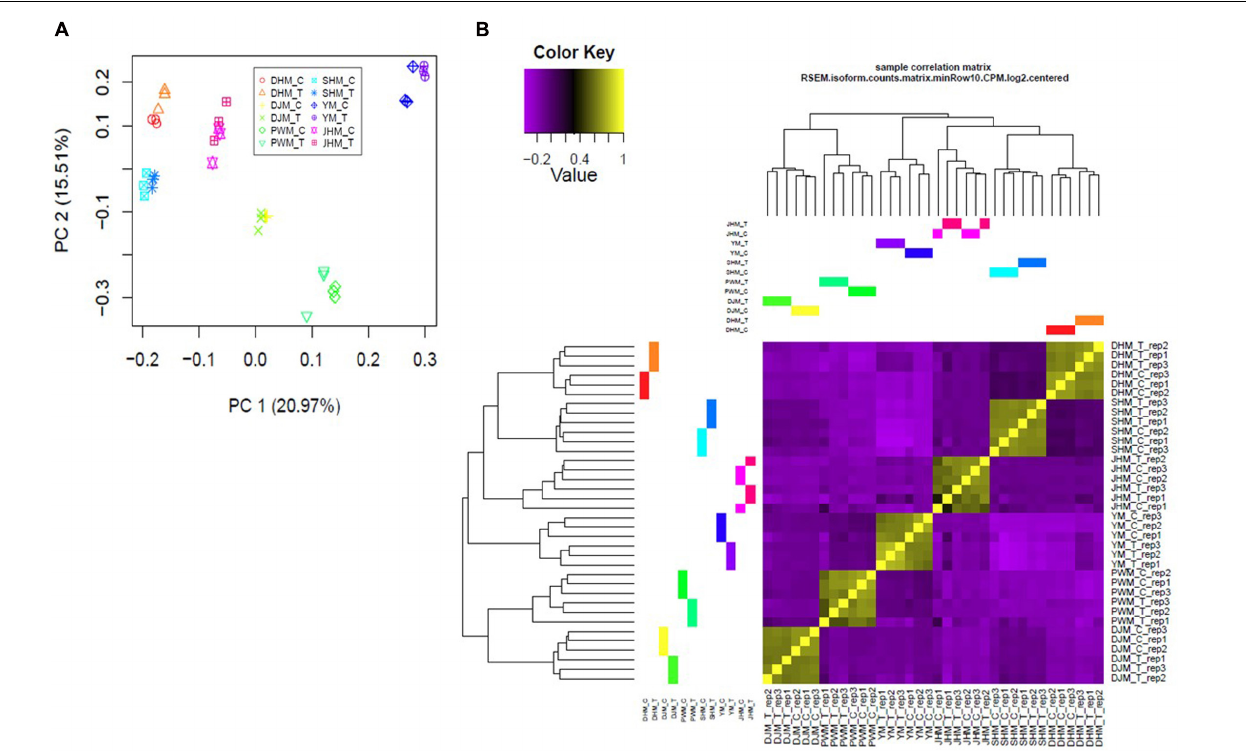
FIGURE 2 | Statistical analysis of differentially expressed genes (DEGs) across samples. (A) Principal component analysis (PCA) of all samples by treatment shows general clustering of samples with a few outliers. Colors denote different cultivars and treatment conditions. (B) Clustered heatmap showing the Pearson correlation matrix of pairwise sample comparisons. The color key was adjusted based on the log2-centered values for optimal visual detection of differences, and the dendrogram illustrates the relationship among samples. DHM, Dahomi; DJM, Danjami; PWM, Pungwonmi; SHM, Shinhwangmi; JHM, Juhwangmi; YM, Yulmi; RCs, resistant cultivars; SCs, sensitive cultivars; C, control; T,